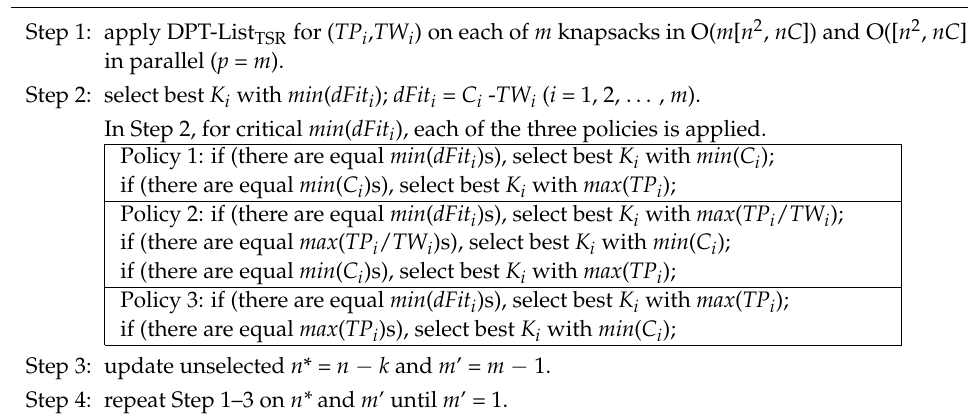
Algorithm 10: multi-DPT-List TSR (the exact-fit (best) knapsack